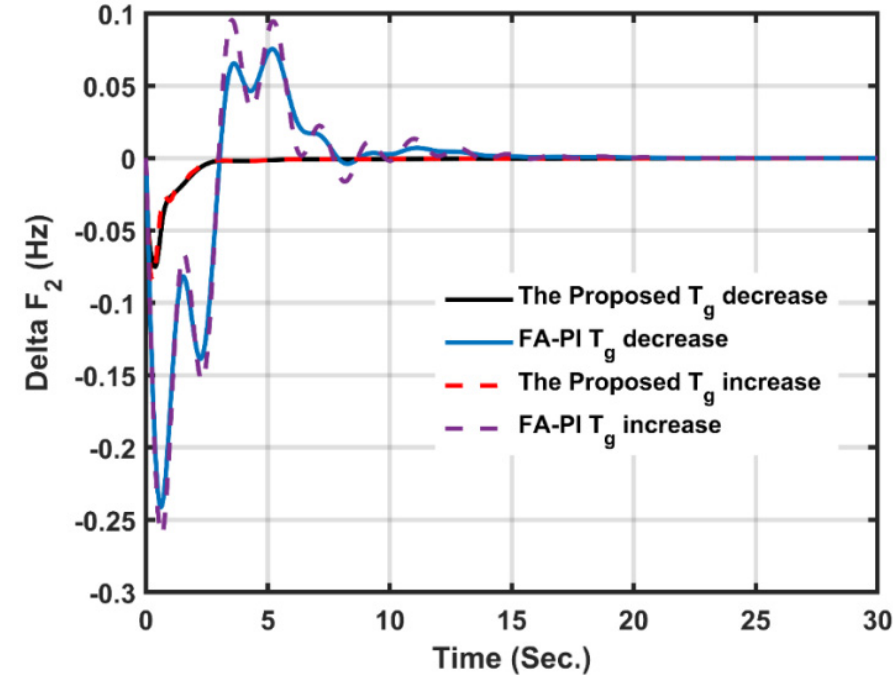
Figure 23. Frequency deviation in area 2 under T g changes.